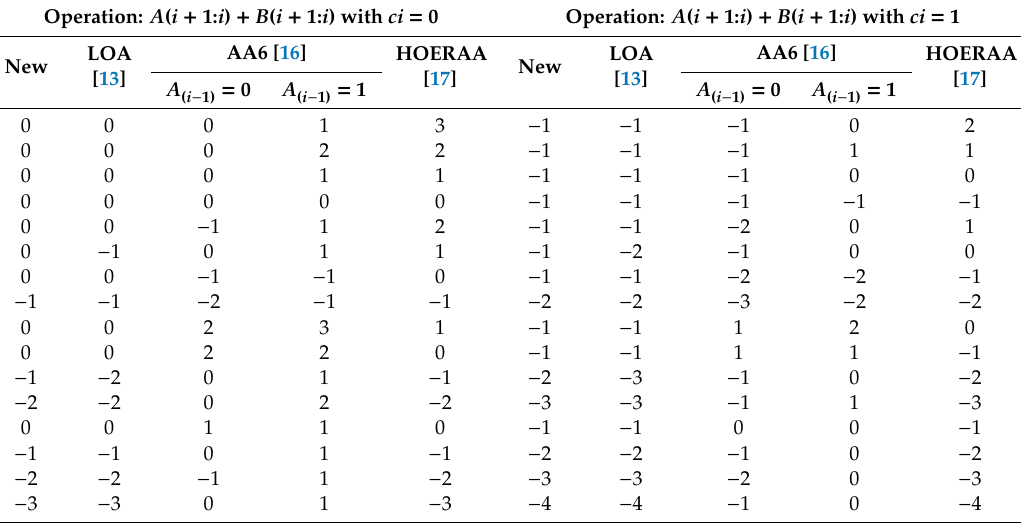
Table 4. Errors introduced by inexact 2-bit addition